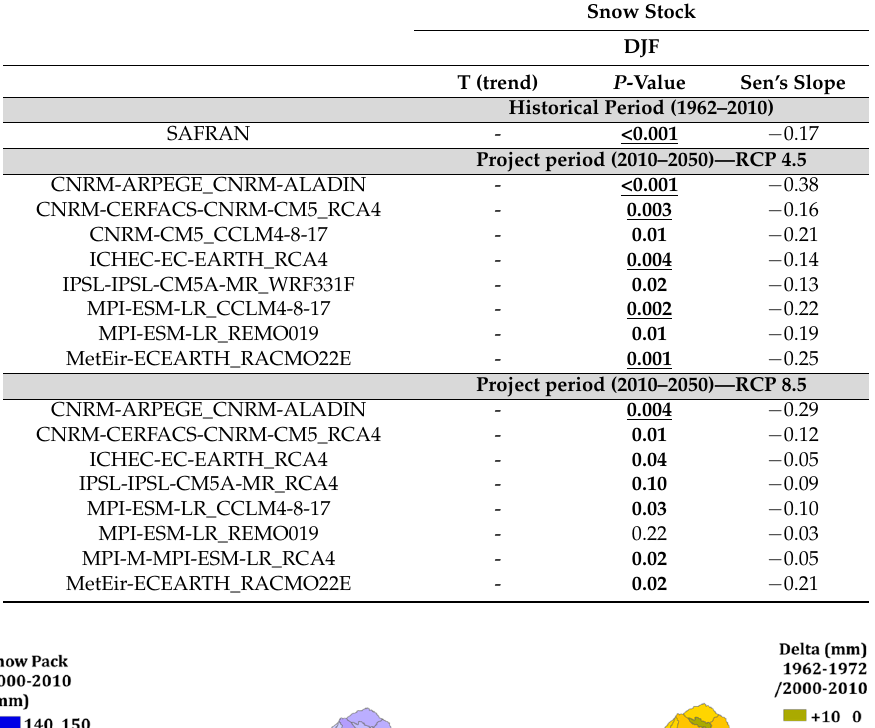
Table 7. Trend in snow stock over winter (DJF) season at watershed scale, for SAFRAN (historical period) and climatic ensemble (projected period). Bold numbers are significant trend considering α = 0.1 and underlined numbers considering α = 0.05.